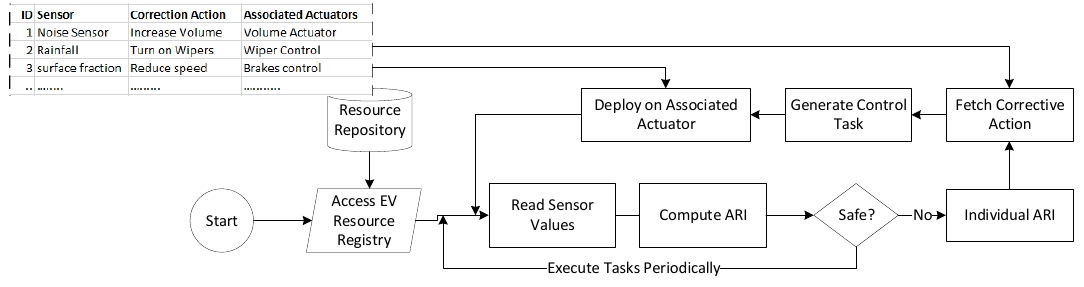
Figure 2. Flow diagram of EV safety profiling and corrective actions in a driver-assistance